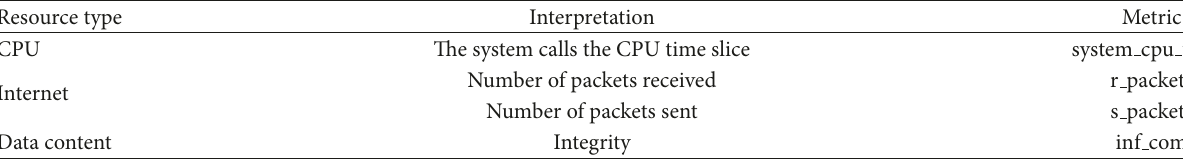
Table 1: Critical monitoring metrics.